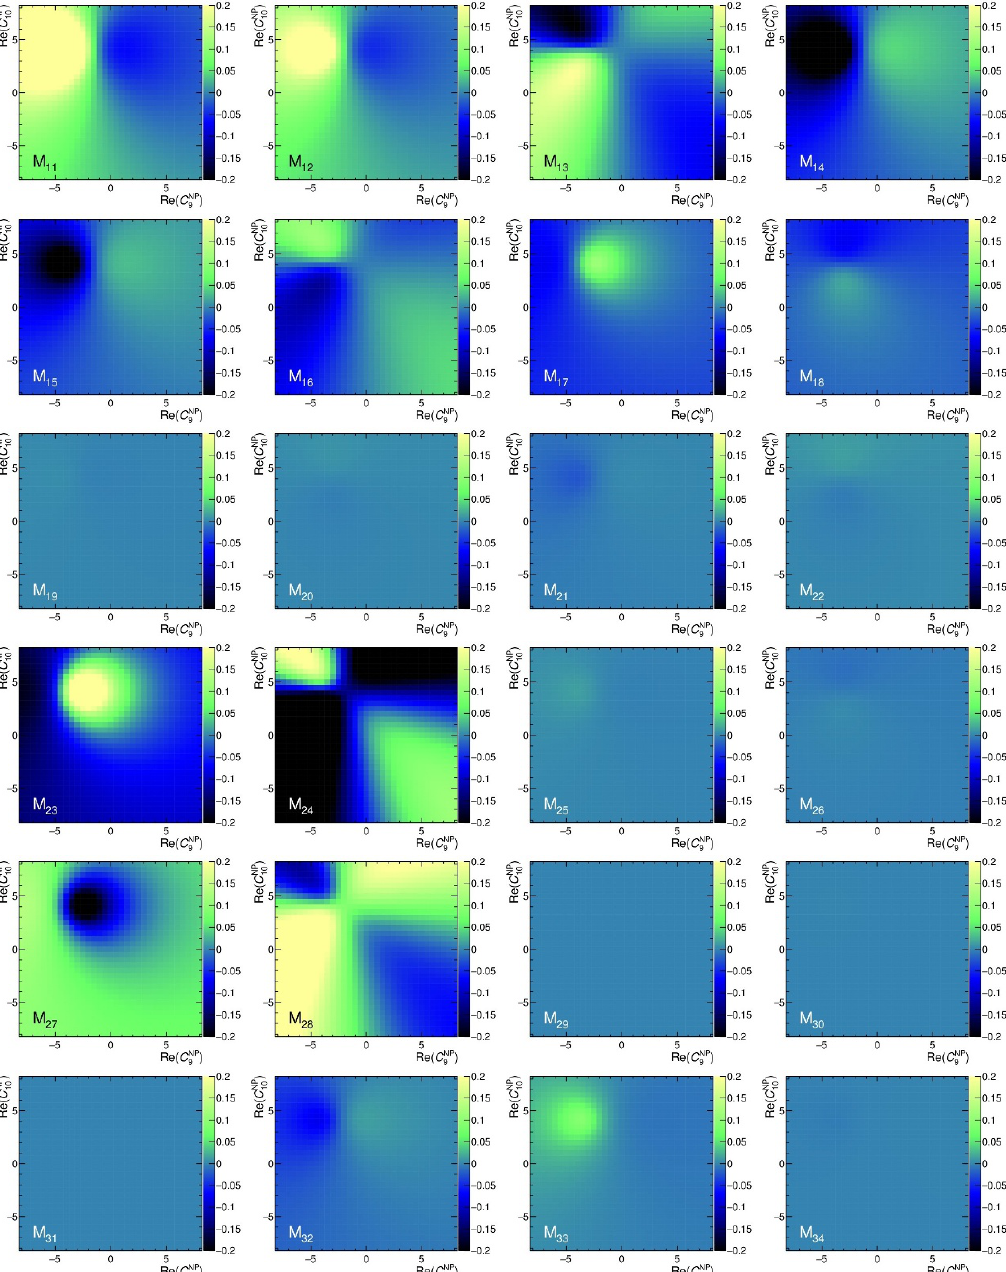
+ (cid:22) (cid:0) decay b ! (cid:3) (cid:22) = 1 b